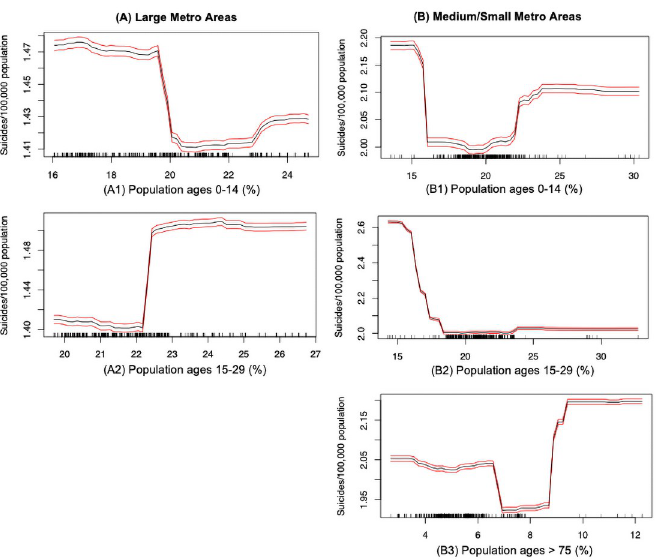
Fig 8. Suicide mortality rate and age: (A) Large metro areas; (B) Medium/small metro areas. Rug lines on the x axis indicate prevalence of data points; black curve is the average marginal effect of the predictor variable; red lines indicate the 95% confidence